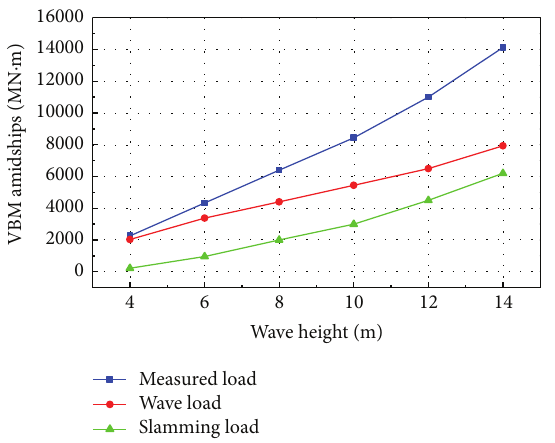
Figure 15: VBM components amidships at different wave heights (scheme 4).